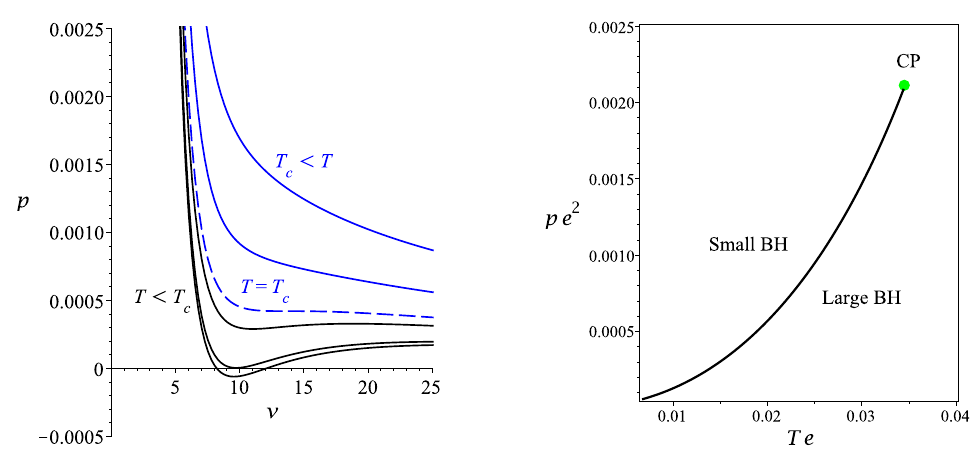
Figure 15 . Critical behaviour in four dimensions . Left : the case for (cid:12)xed charge, we show a P (cid:0) v graph that illustrates a (cid:12)rst order phase transition with VdW behaviour in d = 4 and with k = 1. The various curves correspond to di(cid:11)erent isotherms: at the critical point T = T c (dashed blue line), T = 0 : 9 T c ; 0 : 71 T c ; 0 : 67 T c (solid black lines), and T = 1 : 3 T c ; 1 : 8 T c (solid blue lines). Here we choose (cid:22)=e 4 (cid:25) (cid:0) 0 : 00152 with T c e (cid:25) 0 : 03455. Right : phase diagram in P (cid:0) T plane. The phase